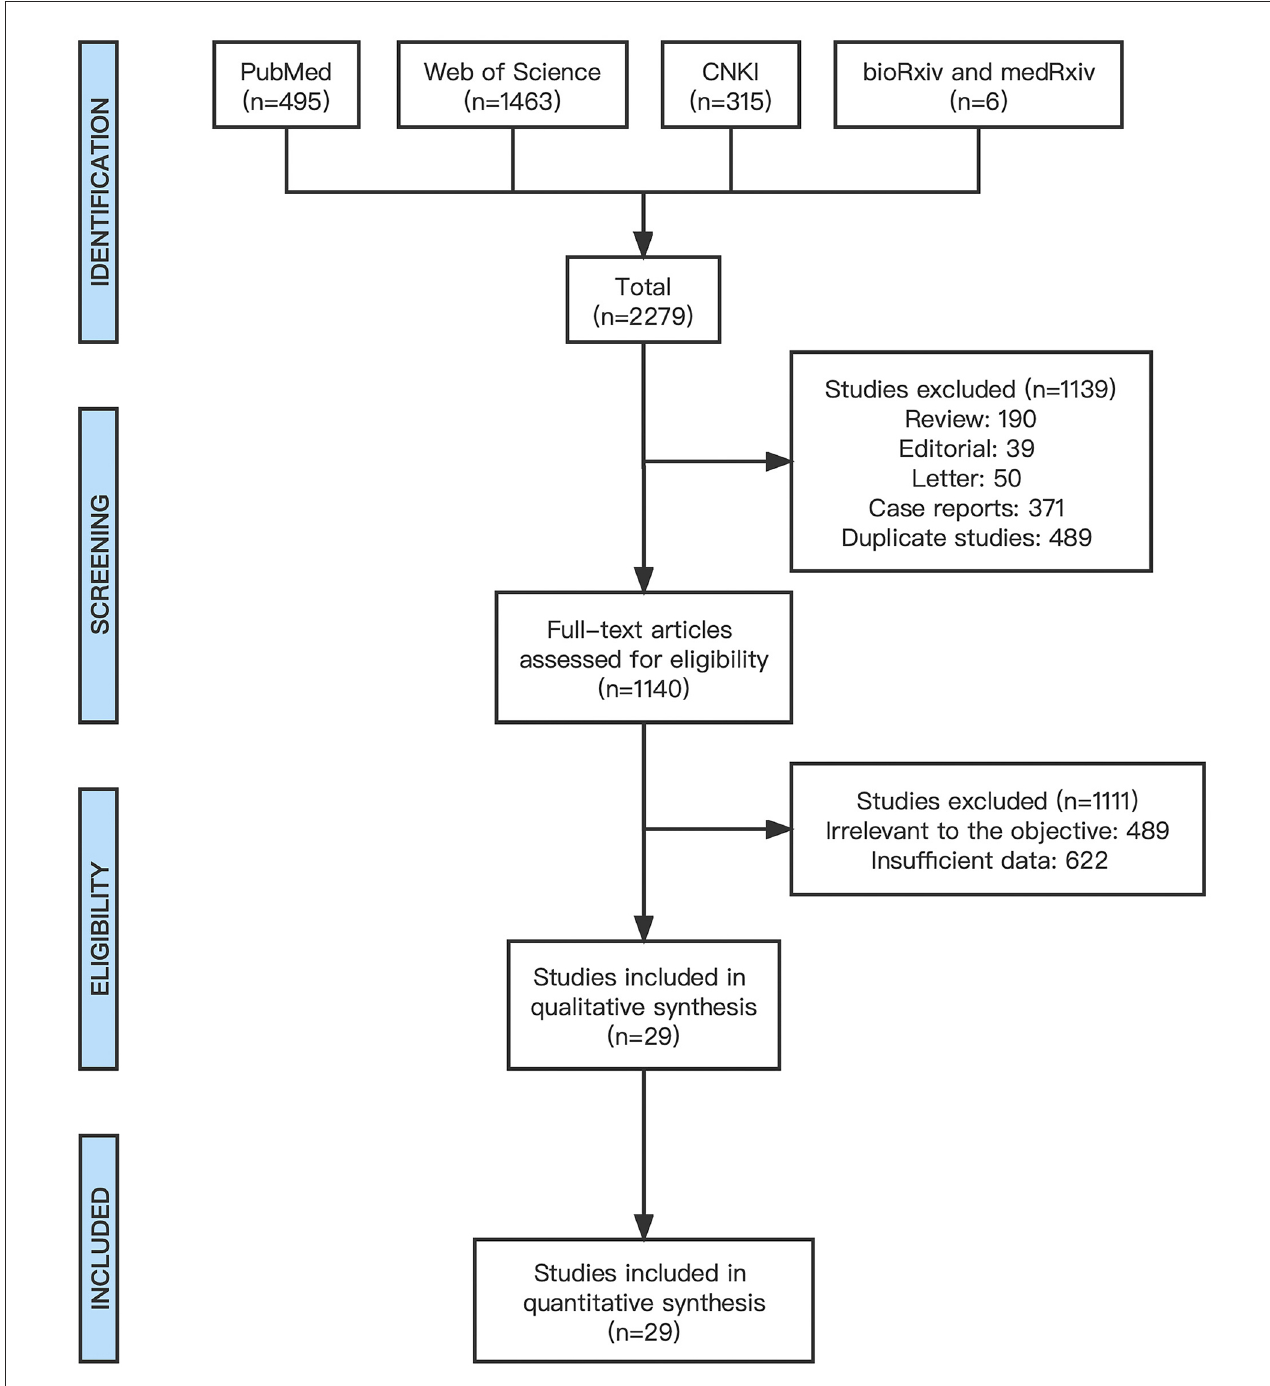
FIGURE1 PRISMA flow